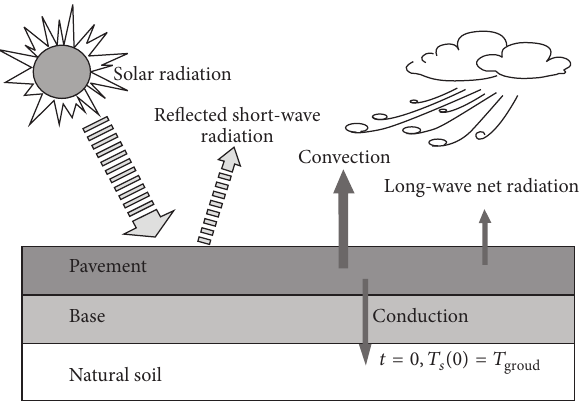
Figure 3: The model of pavement-surface energy balance.